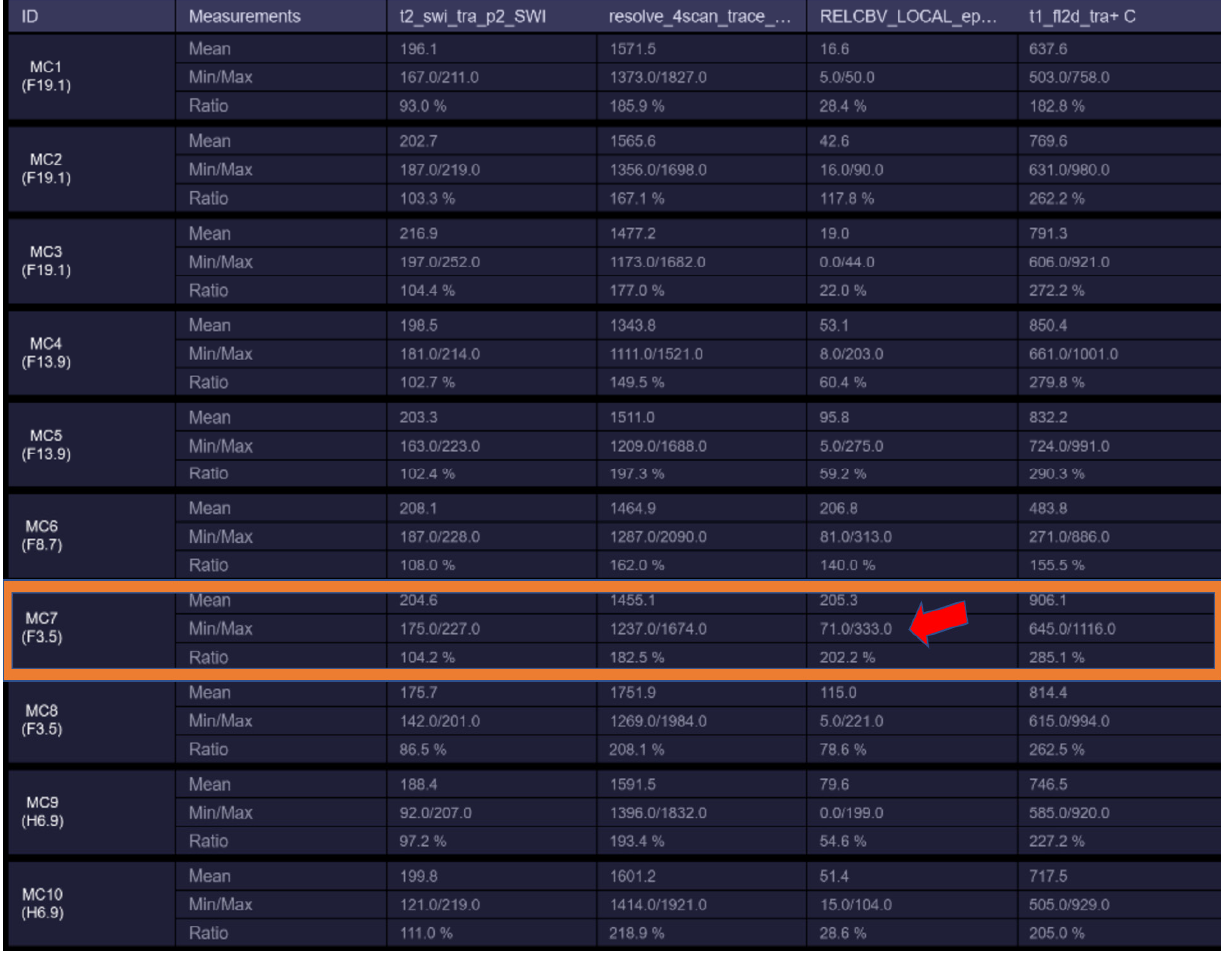
Figure 2. rCBV hyperperfusion indicating neoangiogenesis (MC7—showing rCBV > 1.7–1.9 threshold for neo-angiogenesis).